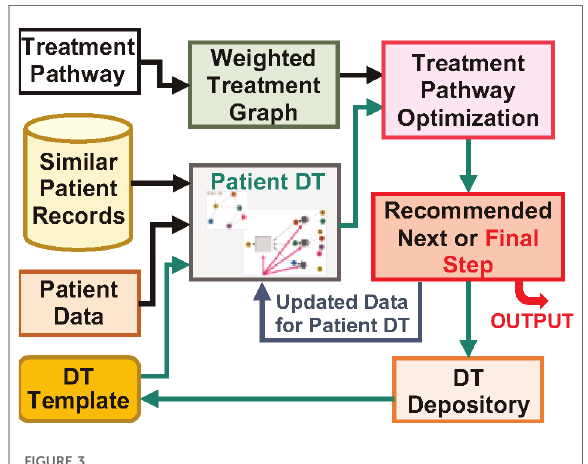
FIGURE 3 The schematic of a multiscale digital twin for a lung cancer